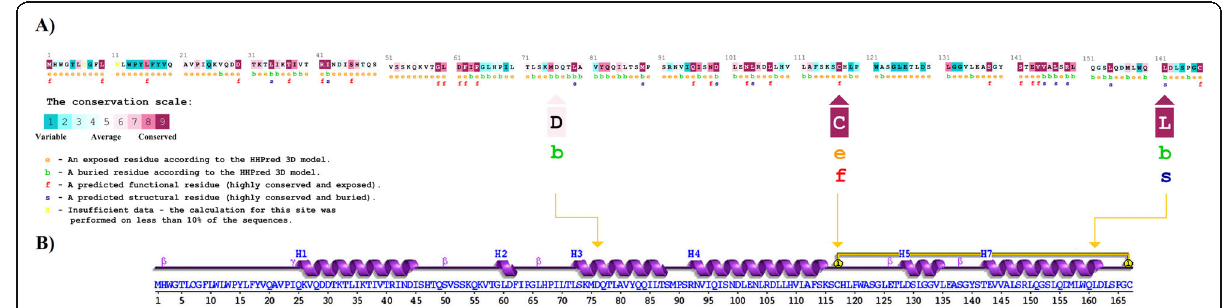
Fig. 2 The positioning of the most deleterious amino acid substitutions identified in leptin. a ) Evolutionary conservation pattern of amino acid residues within the primary sequence of leptin. Color intensity increases with degree of conservation. The amino acids are colored based on their conservation grades and conservation levels. The amino acid positions of the most three deleterious predicted SNPs are maximized below the protein sequence. Both C117 and L161 residues showed higher conserved positions compared with D76 residue. b ) Secondary structure prediction of leptin. Both D76 and L161 amino acid residues are positioned in the alpha-helix region, while the C117 amino acid residue is suited in the highly critical cysteine-cysteine junction. The primary and secondary structures are generated by ConSurf and PolyView-2D tools,